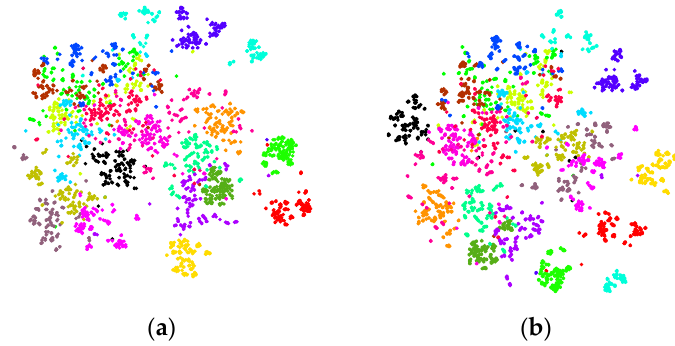
Figure 13. 2-D feature visualization of image global representations learned from UC Merced dataset in condition of: ( a ) Off-the-shelf; and ( b ) Architecture (I). The t-SNE algorithm proposed in [40,41] is used to visualize the high-dimensional representations.